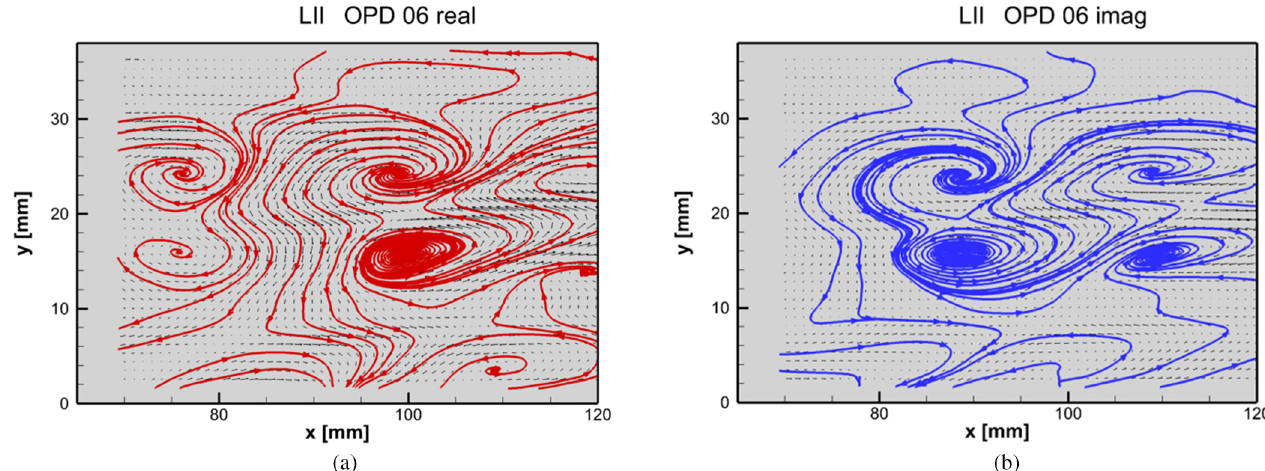
Fig. 22. Topology of the OPD mode in the branch L, zone II, number 6, real (a) and imaginary (b) parts.